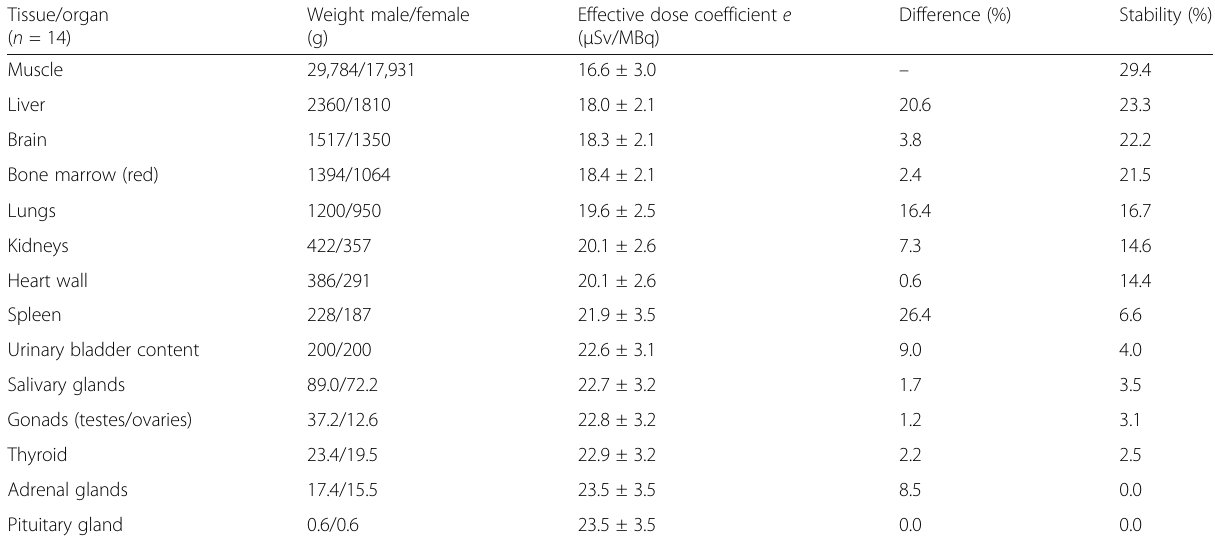
Table 2 Impact of number of tissues/organs included based on decreasing weight including blood from ICRP Publication 133, ICRP Publication 110 voxelized reference phantoms and ICRP Publication 103 tissue weighting factors, w T , to calculate the effective dose coefficient, e , with the SD. The difference in percent calculated according to Eq. 4 and stability according to Eq. 5 Tissue/organ ( n = 14)